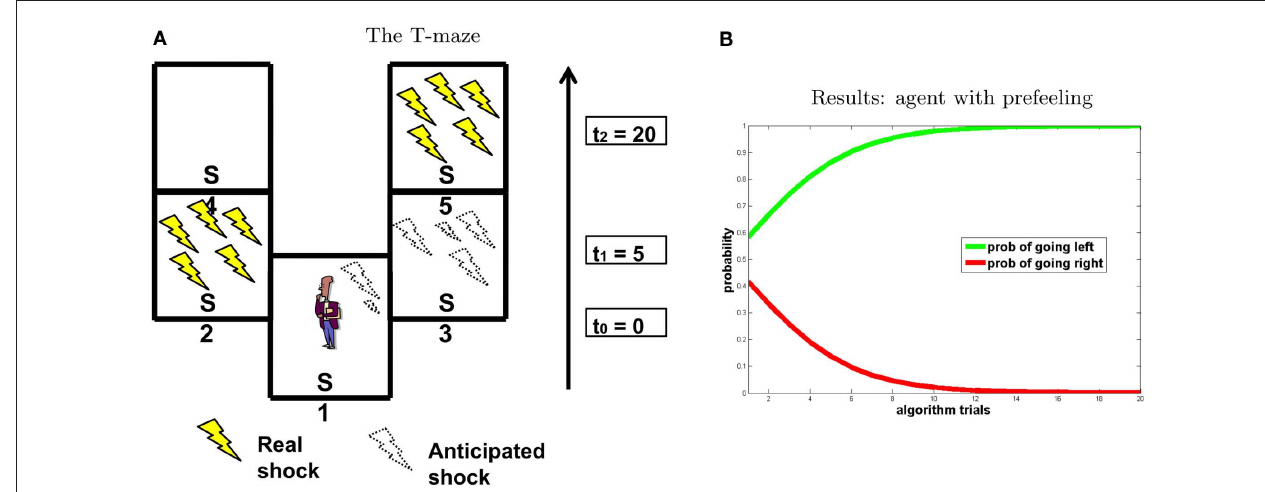
Figure 8 | experiment 4. (A) T-maze. (B) Results, “going right” = red; “going left” =